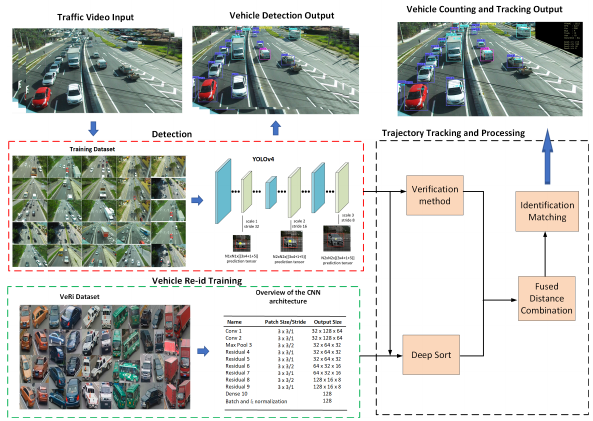
Figure 3. The proposed framework for detection and counting